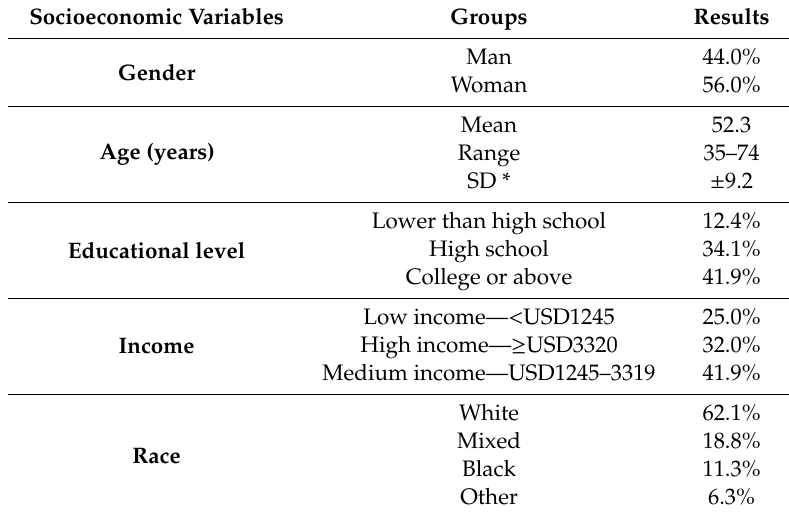
Table 1. Study population sociodemographic characteristics ( n = 3418).